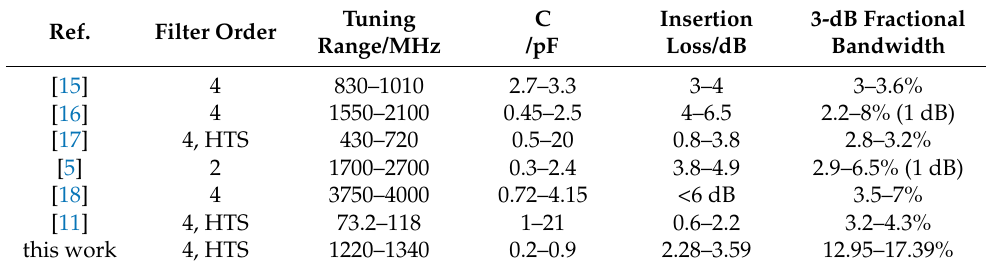
Table 3. Performances of the proposed and other filters.